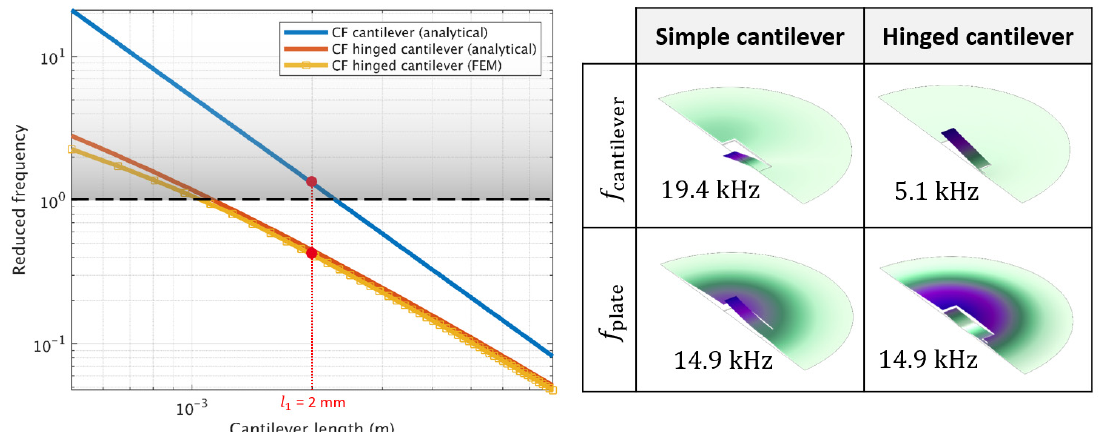
Figure 4. On the left, reduced frequency of the isolated cantilever beam (blue) and hinged cantilever beam (analytical model in red and FEM result with yellow squares) as a function of the length l 1 . On the right, first two eigenmodes of the cantilever-based diaphragm (first column) hinged cantilever-based diaphragm (second column).